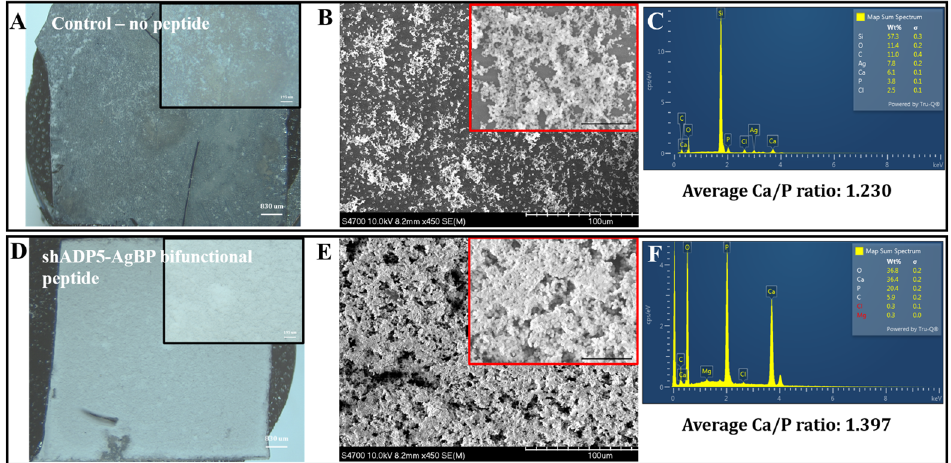
Figure 4. Mineral deposition on silver-coated surfaces. Ag-coated surfaces with no peptide (control, panels A − C ) or 50 mM shADP5-AgBP-treated surfaces (panels D − F ). Optical microscope images ( A , D ), SEM images ( B , E ), EDS spectra ( C , F ), and average Ca/P ratios (insert to C , F ) for mineralized regions after 2 h alkaline phosphate-induced mineralization. Scale bars are 830 mm and 195 mm for insets in ( A , D ), or 10.0 μ m and 25 μ m for insets in ( B , E ).